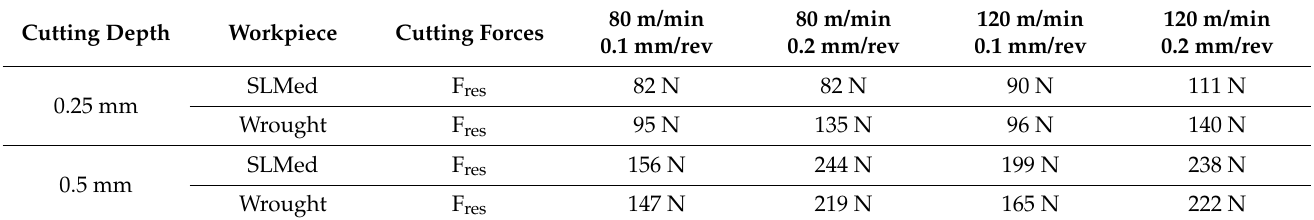
Table 4. The cutting forces when machining wrought and SLMed Ti6Al4V at different cutting parameters. Cutting